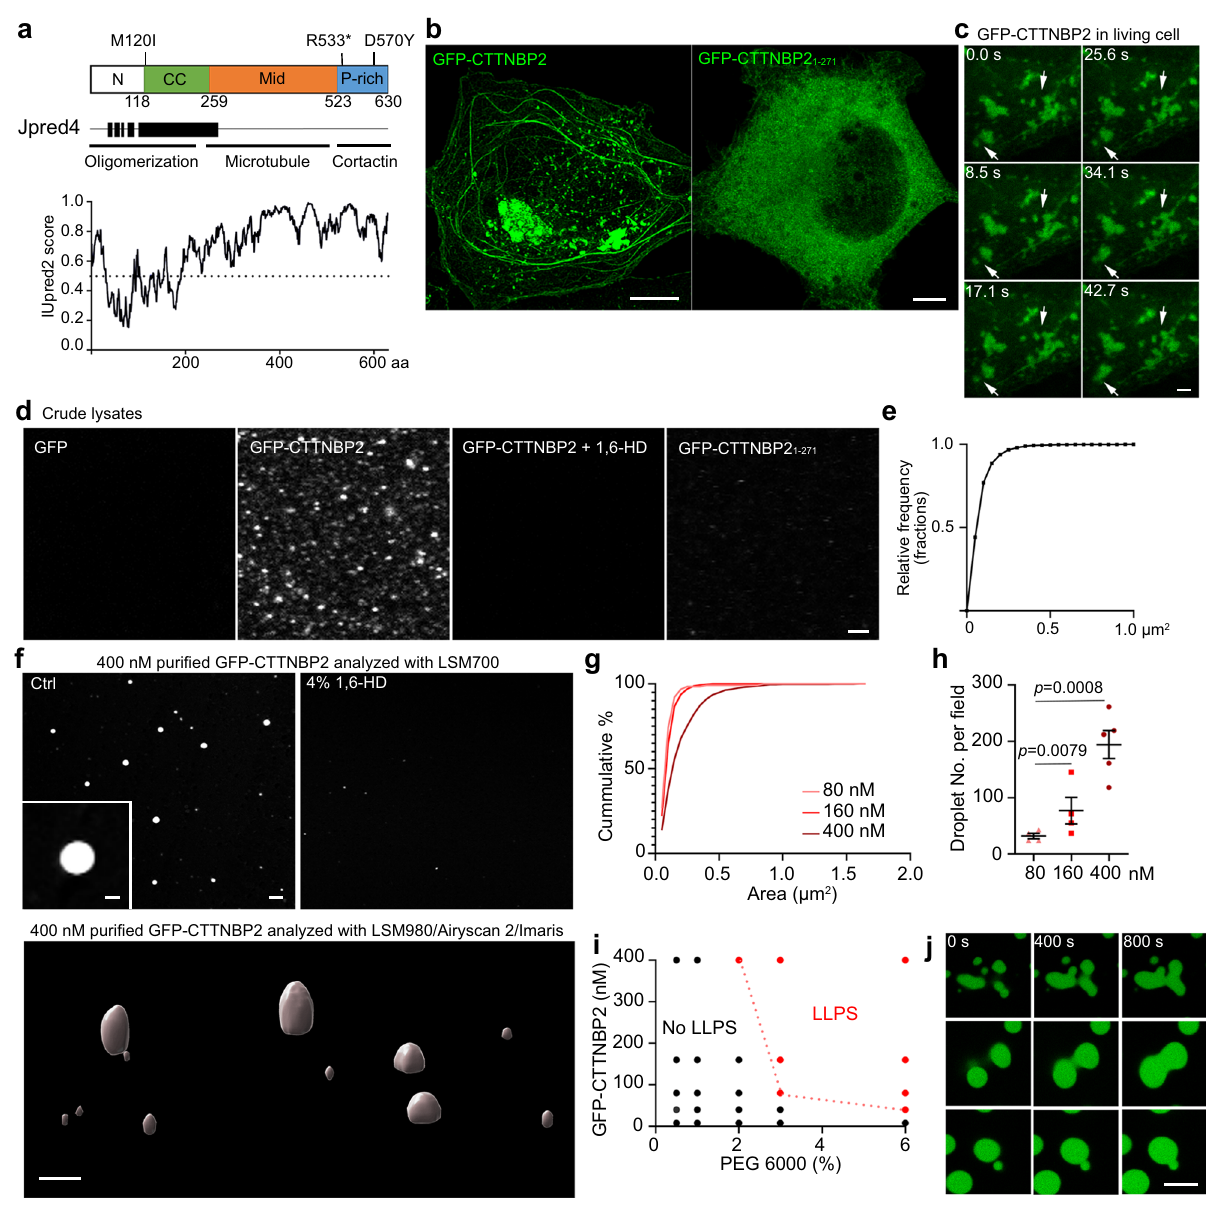
Fig. 1 CTTNBP2, an intrinsically disordered protein, undergoes LLPS in cellulo and in solution. a Predictions of CTTNBP2 protein structure. Upper: Schematic of CTTNBP2 protein domains. Three selected ASD-linked mutations, i.e. M120I, R533* and D570Y, are highlighted. Middle: Jpred4-predicted α - helical secondary structures are shown as black blocks. CTTNBP2 domains and corresponding functions are indicated. Bottom: IUpred2A-predicted intrinsic disorder of CTTNBP2. Higher scores indicate a greater degree of disorder. b Confocal images of COS1 cells expressing GFP-CTTNBP2 and